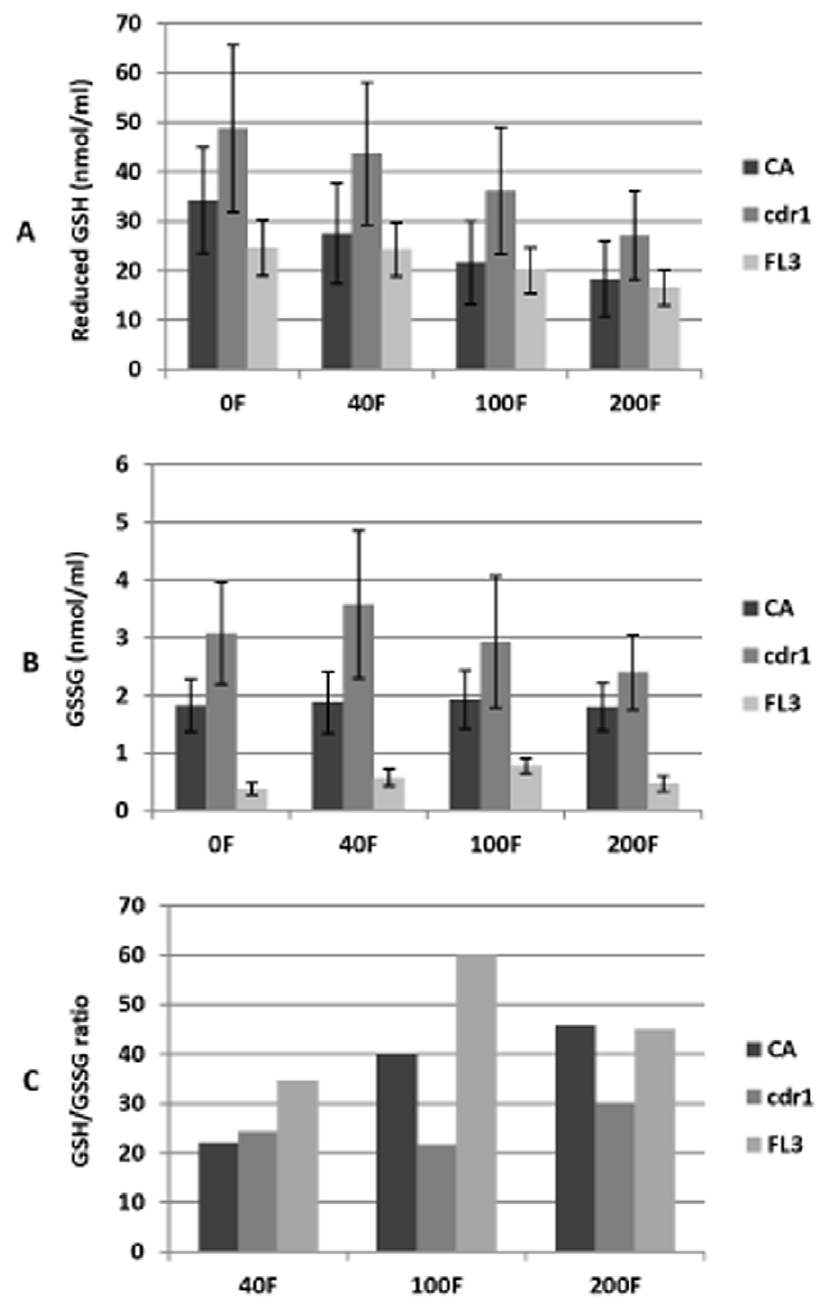
Figure 4. Effect of farnesol on intracellular GSH/GSSG homeostatis and redox balance. Significant reduction in GSH levels proportional to farnesol concentration with FL3 exhibiting lowest levels and highest disruption in ratio whereas cdr1 had highest GSH levels with minimal changes in ratio noted. Error bars indicate the standard errors of the means.